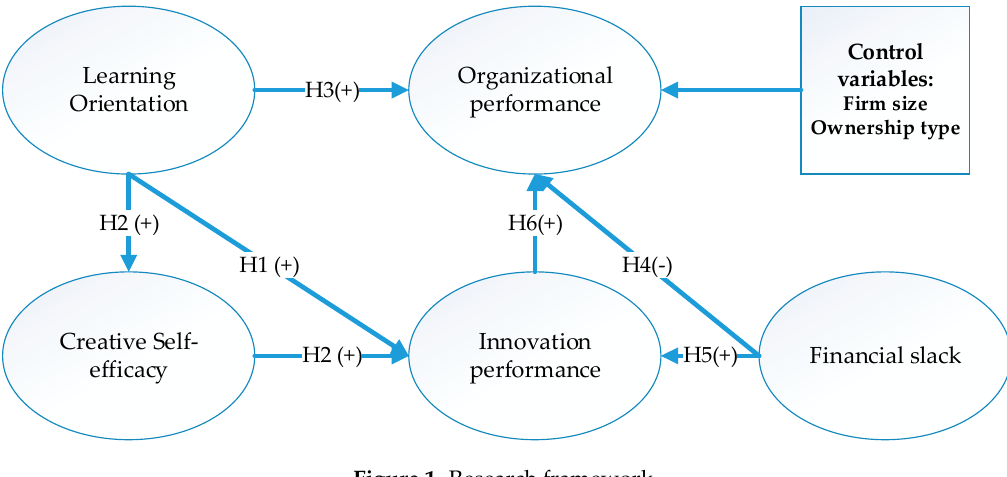
Figure 1. Research framework.